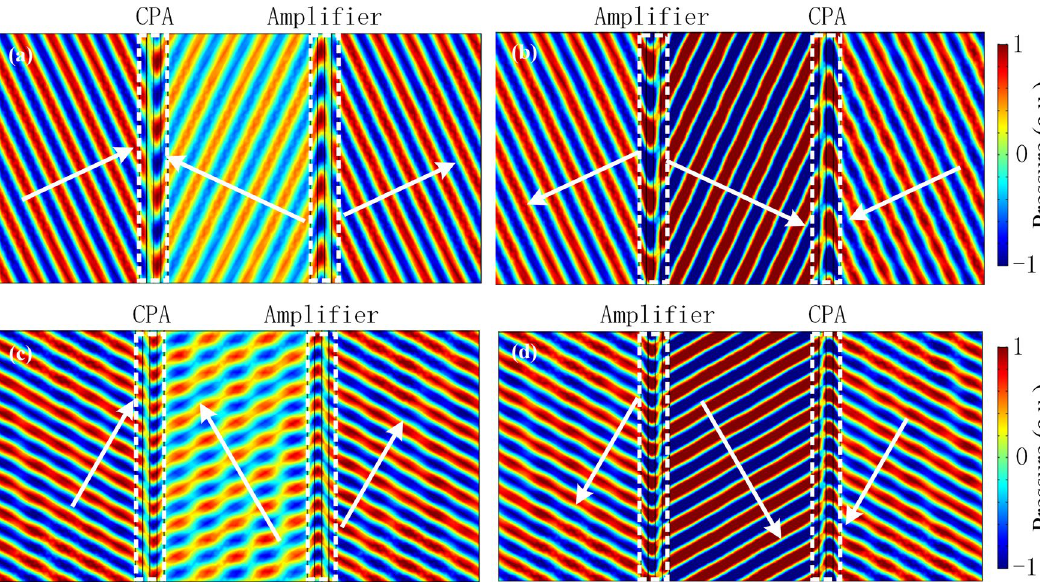
Figure 5. Pressure field distributions of the bidirectional acoustic negative refraction system for the obliquely incident plane wave at the operating frequency of f = 3,400 Hz. The angles of obliquely incident waves are set to 25 60 ( a ), ( b ) θ ◦ and ( c ), ( d ) θ = ◦ , respectively. The white arrows represent the direction of the power flow. In = ( a ) and ( c ), the plane wave is incident from the left side. In ( b ) and ( d ), the plane wave is incident from the right